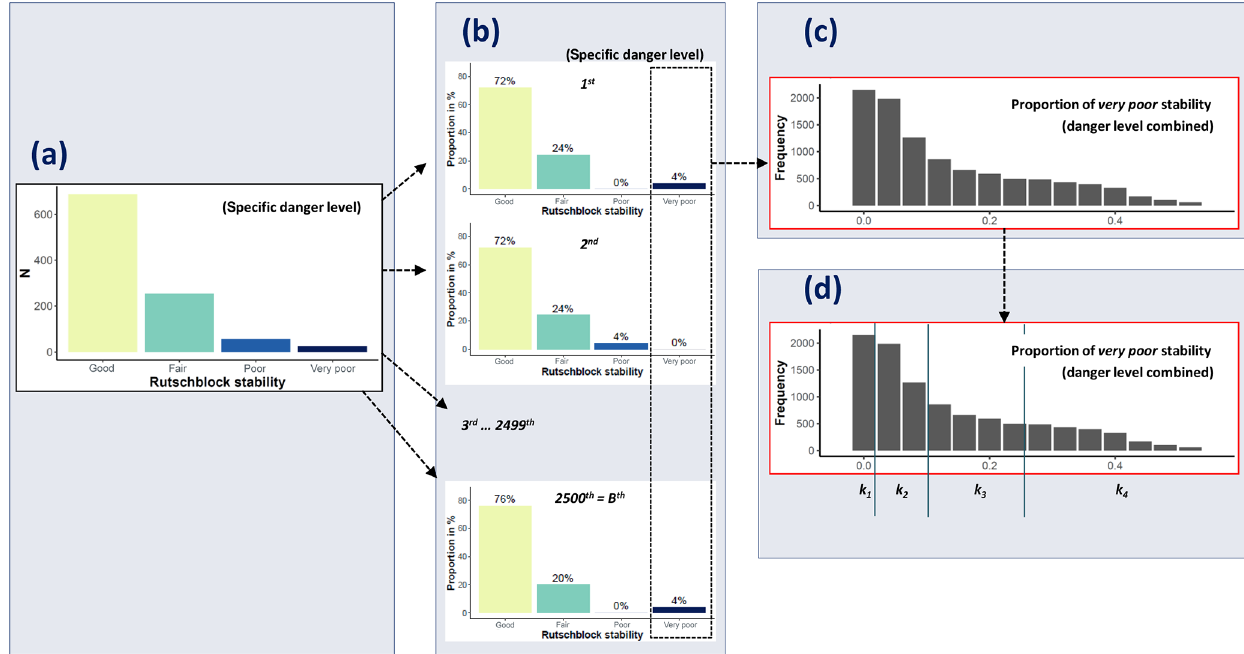
Figure 2. Schematic representation of the workflow for bootstrap sampling and frequency class definition. (a) For each danger level, all stability ratings are combined. (b) From the observed stability distributions of a specific danger level (a) , n tests are randomly sampled. This is repeated B = 2500 times to obtain typical stability distributions for each of the four danger levels. (c) The 4 × 2500 bootstrap samples are merged, and the proportion of very-poor-rated stability tests per sample is plotted as a histogram, irrespective of danger level. (d) The statistics required for frequency class definitions are calculated, and the k frequency classes defined. For details refer to the description in Sect. 3.2 and